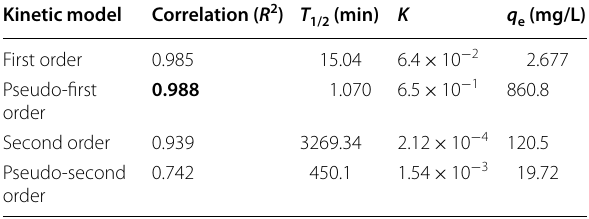
temperatures ranging between 5 and 45 °C after 30 min (Fig. 6). An increase in temperature leads to an increase in percentage Cr (VI) reduction, and complete reduc- tion was achieved at 15 °C at the lowest pH of 2.